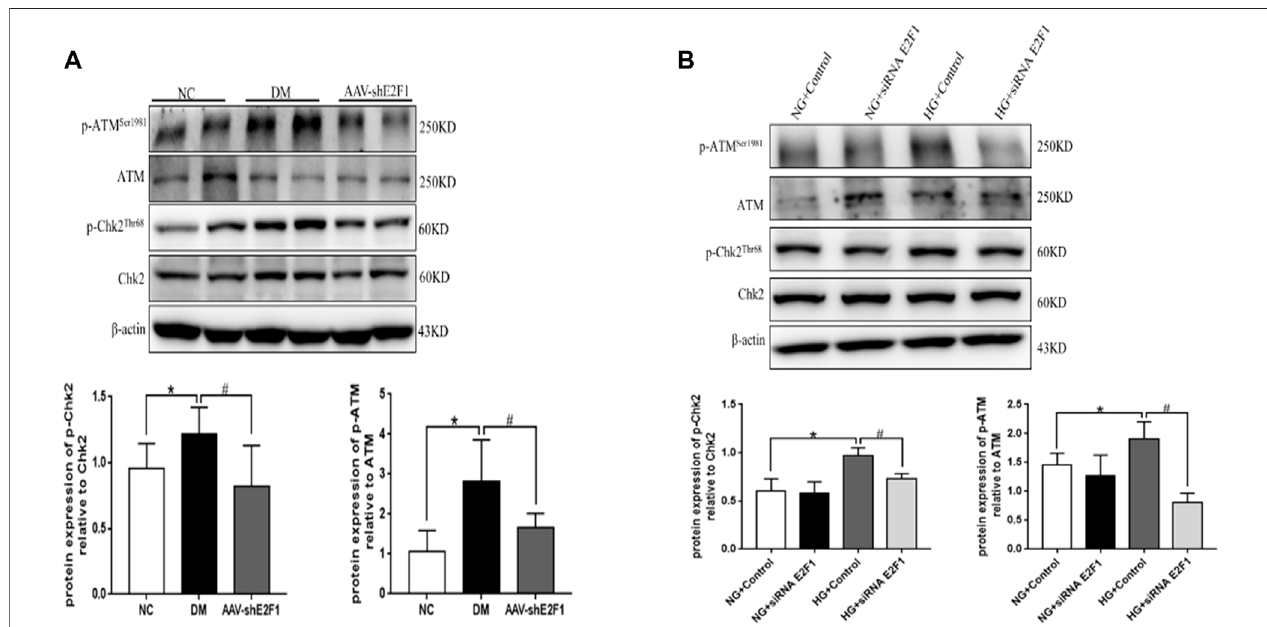
FIGURE6| HighexpressionofE2F1promotesDNdamageinrenaltubularepithelialcellsinthehigh-glucosestate. (A) WesternblotanalysisofATM,p-ATM Ser1981 , Chk2, and p-Chk2 Thr68 in the renal cortex of mice in each group (n = 6, * p < 0.05 vs. NC, # p < 0.05 vs. DM). (B) Western blot analysis of ATM, p-ATM Ser1981 , Chk2, and p-Chk2 Thr68 in mRTECs (n = 3, * p < 0.05 vs. NG + Control, # p < 0.05 vs. HG +